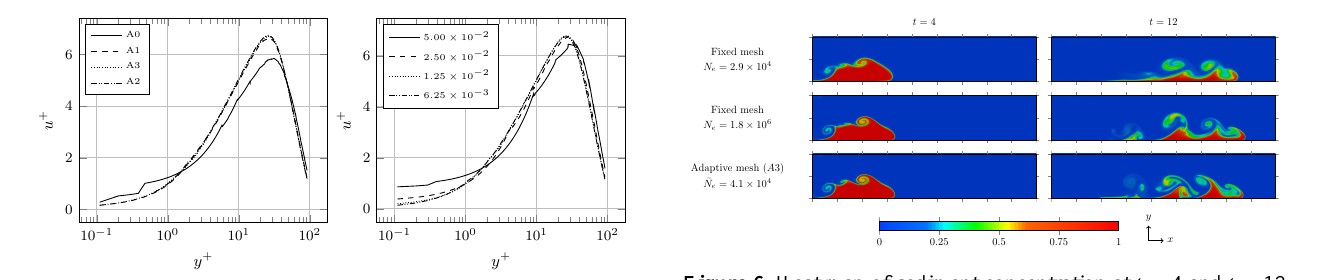
Fig. 4: Energy budget evolution with time for simulation with adaptivity options A 3 (solid lines —) compared against 2-D resultsfromEspathetal.(2014)(dashedlines---).Valuesarenormalisedbytheinitialpotentialenergy, E T .